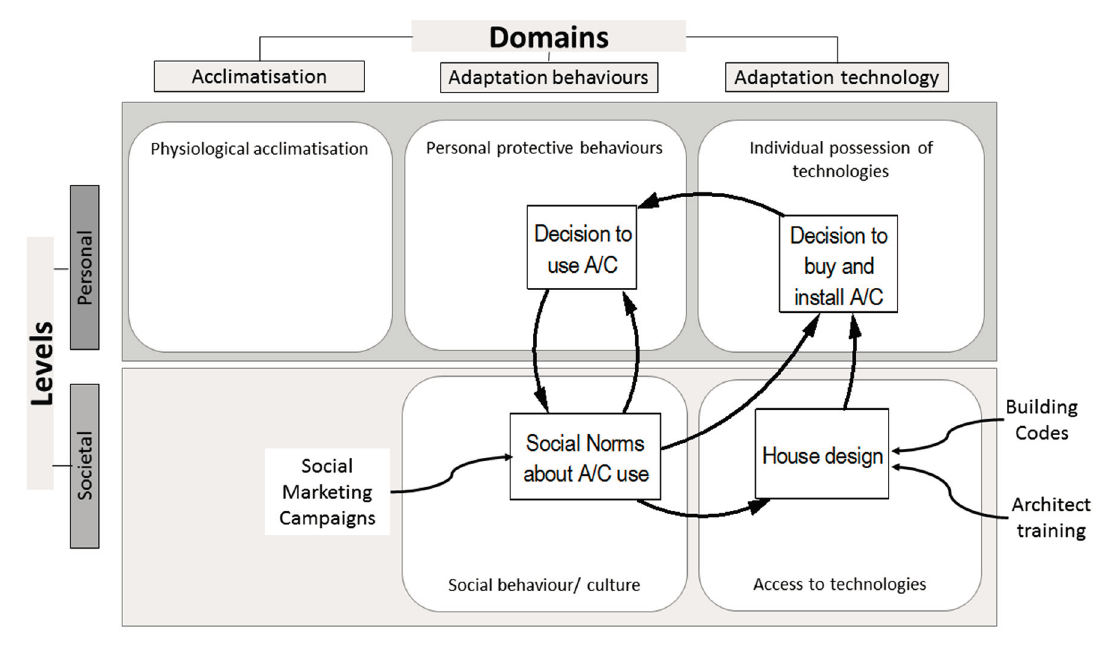
Figure 4. Social norms-house design-air conditioning use feedback loops. Further illustration of the use of the CCAC framework, here populated only by relevant elements of a single feedback loop relating to house design and A/C, and introducing examples of strategies that could be applied (external